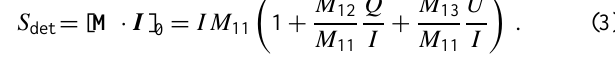
Table 1. SCIAMACHY PMDs, their spectral range, average wave- length, corresponding SCIAMACHY science channel and average polarization sensitivities for limb